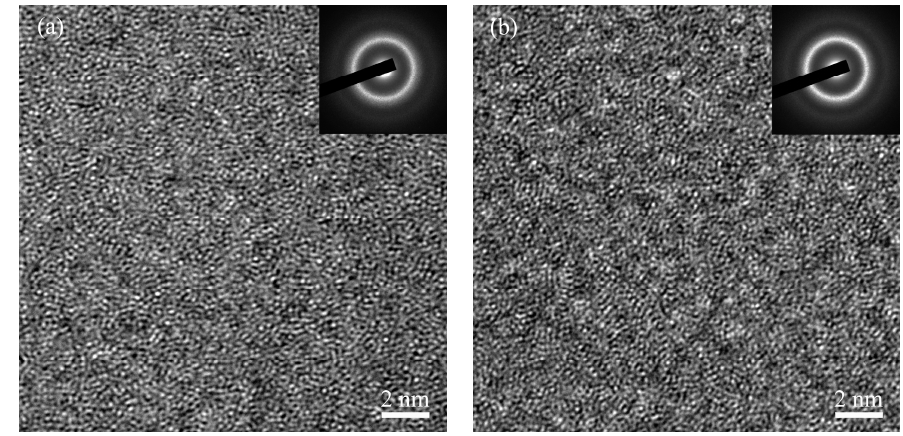
Figure 3. High resolution TEM images and SAED patterns of Zr 70 Cu 12.5 Ni 10 Al 7.5 ( a ); and Zr 65 Cu 12.5 Ni 10 Al 7.5 Ag 5 ( b ) alloys.